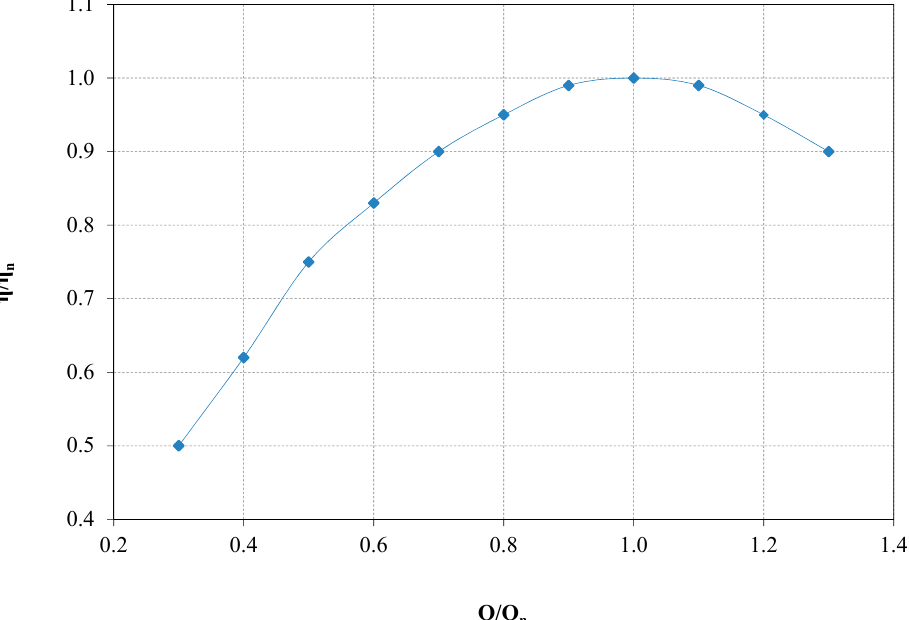
Figure 3. Relationship between the ratio of real and minimal efficiency vs. the ratio of real and nominal gas flow.